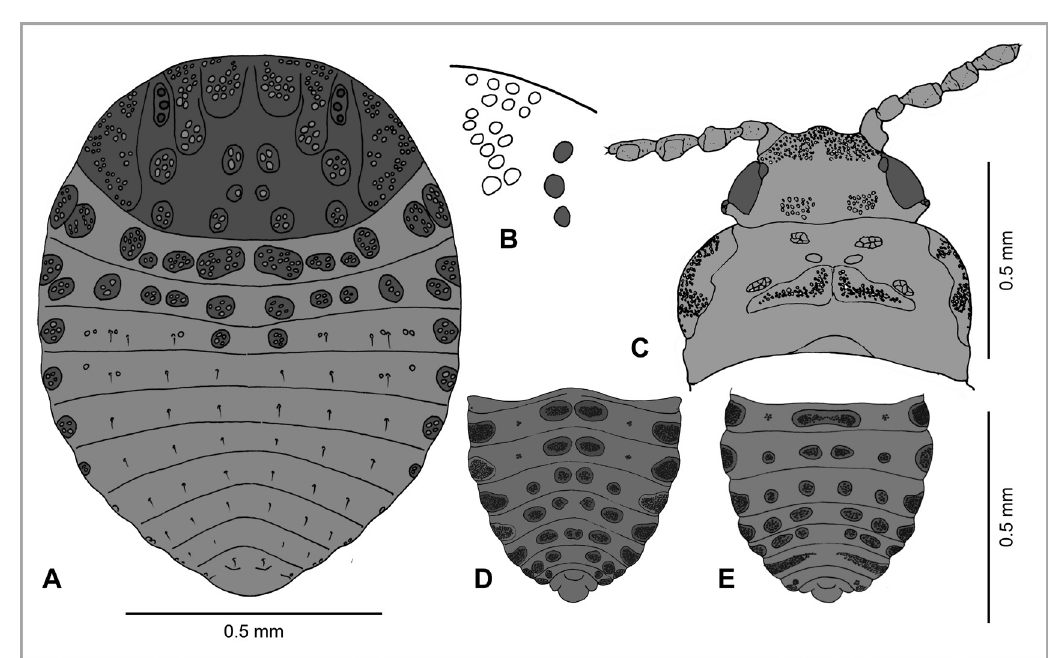
Fig. 75. Pineus (Pineus) pini (Macquart, 1819). A . Adult aptera (after Inouye 1953, modified from Pashchenko 1988). B . As A, showing outer intraocular group of wax gland pits. C . Adult alata, head and prothorax, showing arrangement of wax glands (after Carter 1971, modified from Heie 2004). D–E . Adult alata, abdomen (after Börner, modified from Heie 2004).